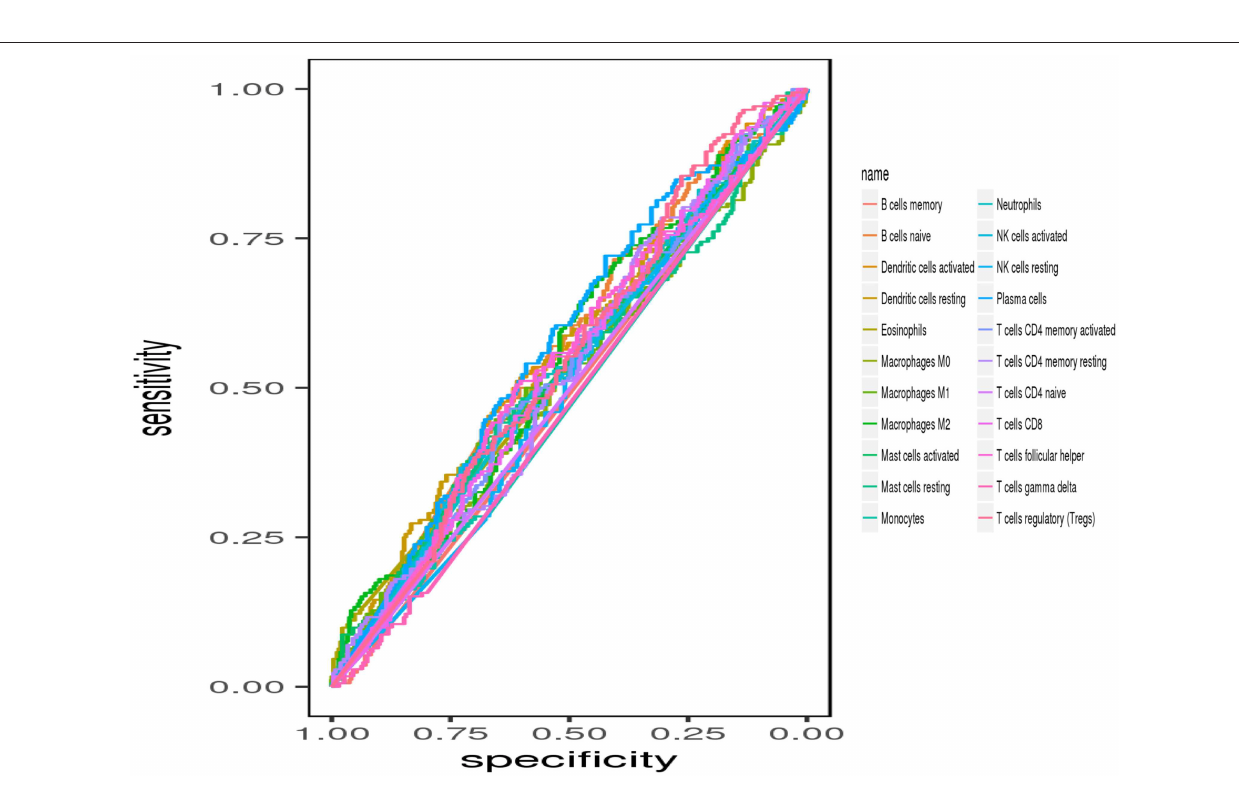
Frontiers in Oncology |